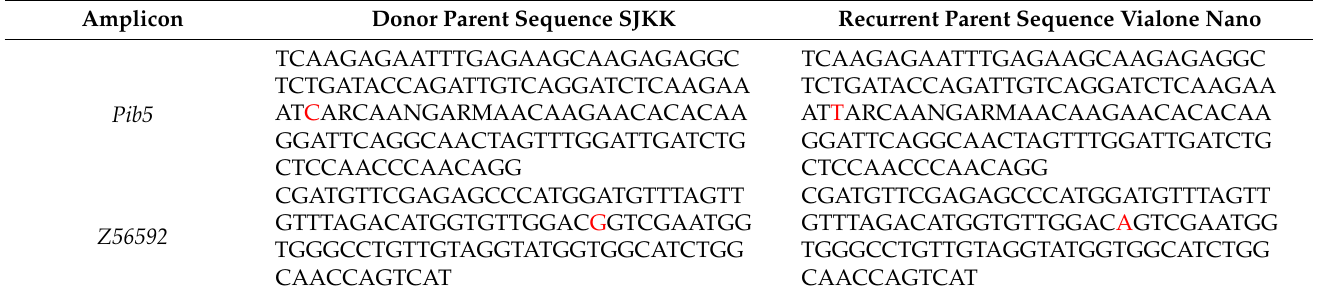
Table 2. Sequences for each Pi gene marker used for the KASP marker assay development. The selected SNPs are indicated in red. Within the sequences, the IUPAC Code characters R, W, S, Y, M are used, indicating the presence of unselected other SNPs following the encoding R = A/G, W = A/T, S = C/G, Y = C/T, M = A/C. The N character indicates presence of